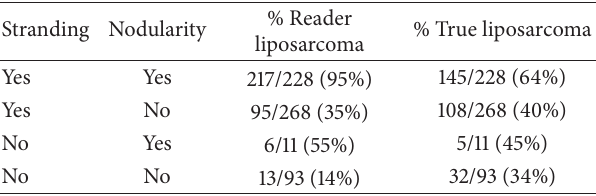
Table 2: The relationships of stranding and nodularity to the diagnosis of liposarcoma.